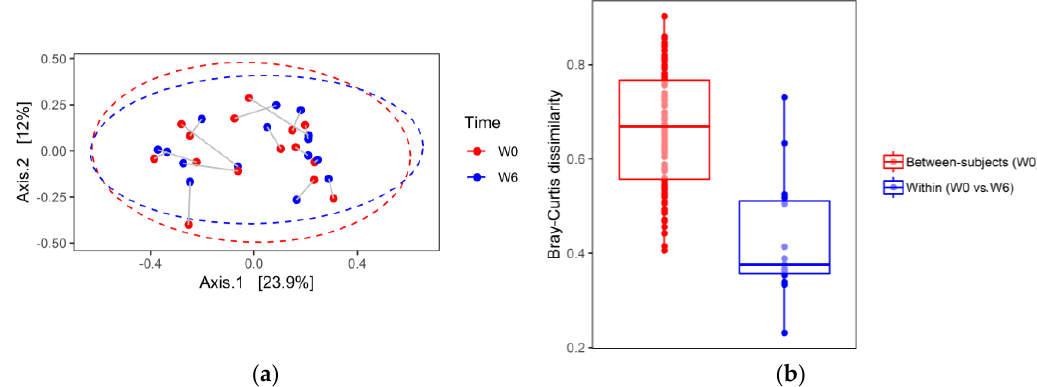
Figure 6. Gut microbial composition changes during six weeks of hospitalization in patients with a depressive episode, treated with escitalopram. ( a ) Principal coordinate analysis based on Bray – Curtis dissimilarities calculated using normalized count data, median sequencing depth, and the five most abundant phyla. Two outlier samples were removed (one male and one female), n = 15. Samples are colored according to time points. Grey lines connect projections of samples from the same patients. Ellipses correspond to 95% confidence intervals for two time points (W0 and W6) assuming a multivariate normal distribution. ( b ) The boxplot shows Bray – Curtis dissimilarities (center line — median, lower, and upper hinges correspond to the first (Q1) and third (Q3) quartiles; whiskers — the upper whisker is located at the smaller of the maximum Bray – Curtis measures and Q3 + 1.5 × IQR (Q3 − Q1); the lower whisker is located at the larger of the minimum Bray – Curtis measures and Q1 − 1.5 × IQR). W0 and W6 represent time points.